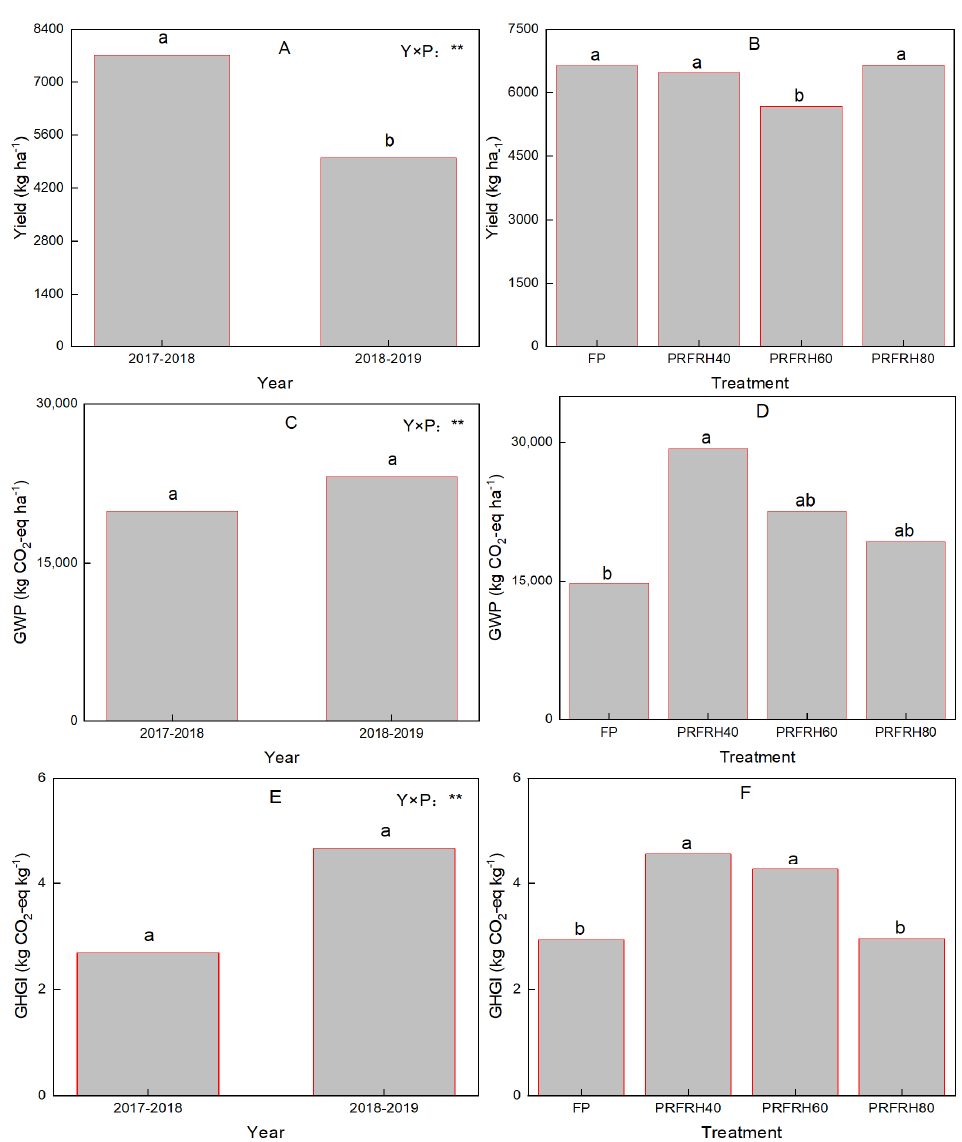
Figure 7. Effects of different precipitation year, planting pattern and the interaction between pre- cipitation year and planting pattern on winter wheat yield ( A , B ), GWP ( C , D ), and GHGI ( E , F ) in 2017–2019. Same lowercase letters indicate data without significant differences at p < 0.05 level. ** Significant at p < 0.01, respectively.